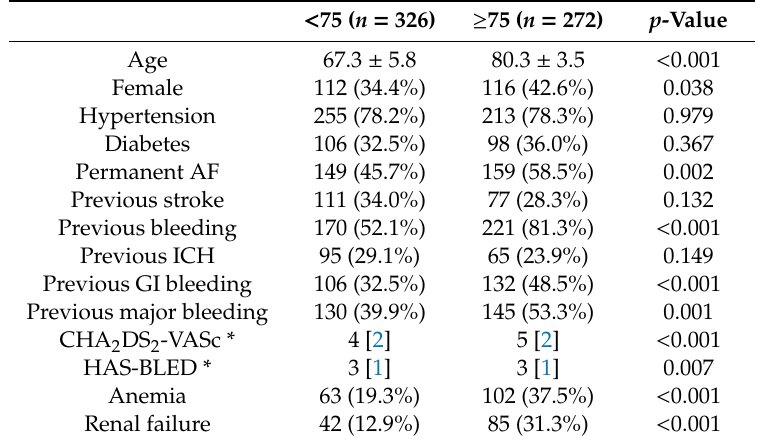
Table 1. Clinical variables in the populations aged < 75 and ≥ 75 years.